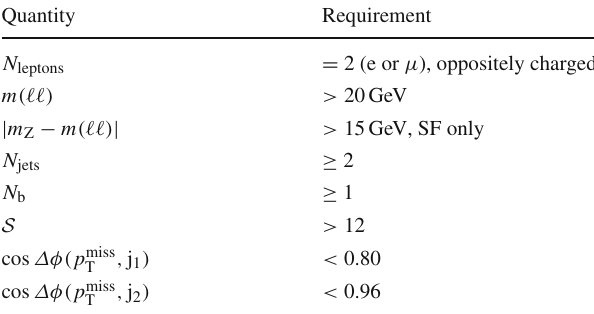
Table 2 Overview of the event preselection